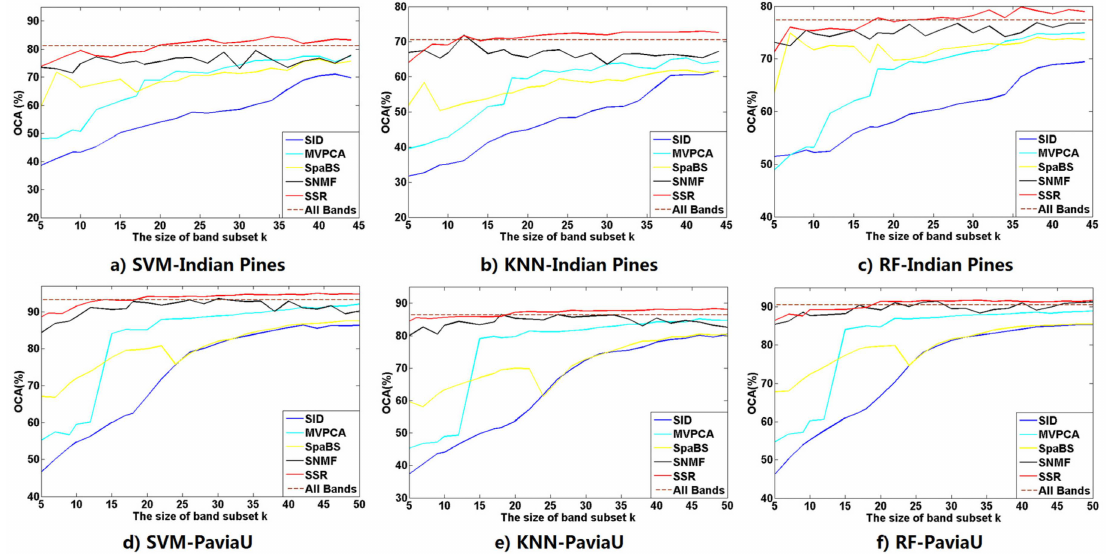
Figure 3. The OCA plots from SVM, KNN and RF classifiers on Indian Pines and PaviaU datasets. ( a ) SVM-Indian Pines; ( b ) KNN-Indian Pines; ( c ) RF-Indian Pines; ( d ) SVM-PaviaU; ( e ) KNN-PaviaU; and ( f )